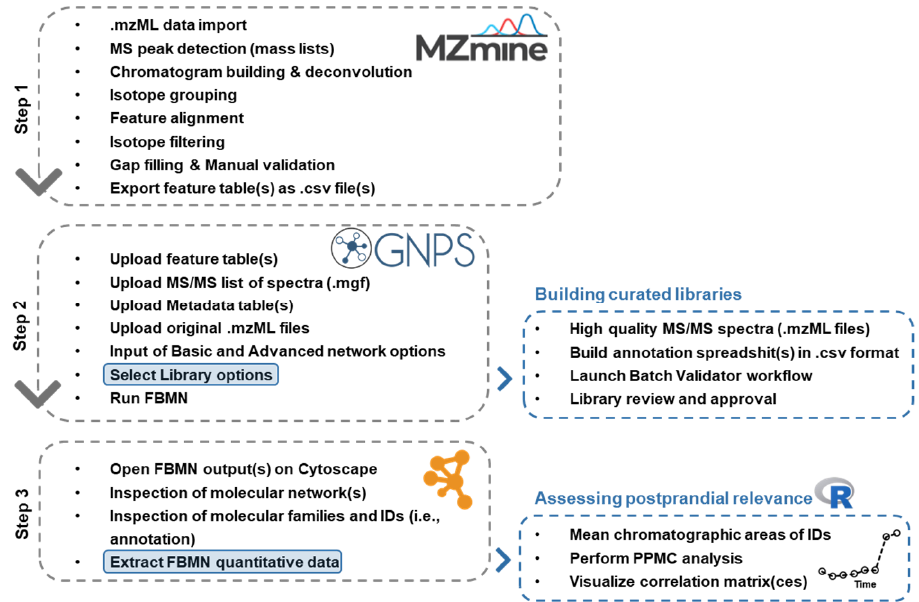
Figure 1. Schematic representation of the available (grey dashed lines) and proposed (blue dashed lines) workflows of data management, applied by the combination of Feature-Based Molecular Networking and the “Nutri-Metabolomics” mass spectral libraries that were manually curated.